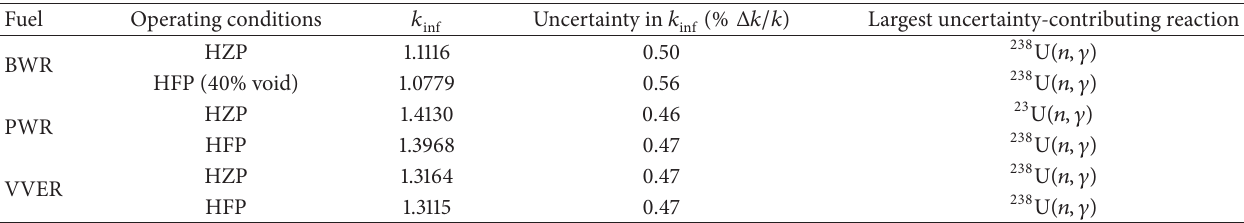
Table 2: Assembly 𝑘 inf values and associated uncertainties.